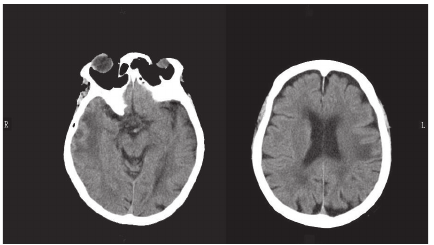
Figure 2: Brain CT performed during emergency care revealing a low density area with a nodular structure in the lower part of the right temporal lobe and a smaller low density area in the left paraventricular subcortical area suggestive of brain metastasis and brain